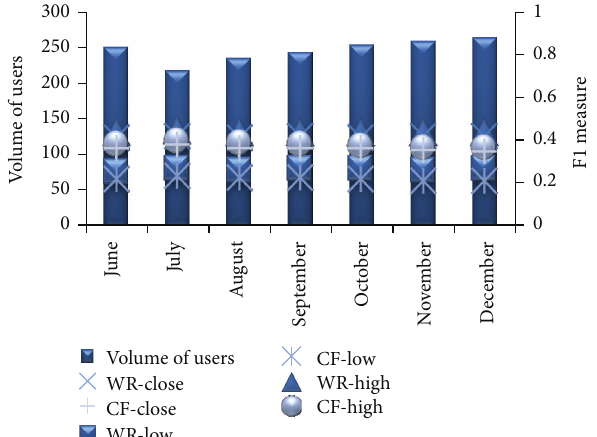
Figure 15: WebBluegillRecom-annealing system (WR) is compared to standard collaborative filtering (CF) system on coverage for different volume of users in different